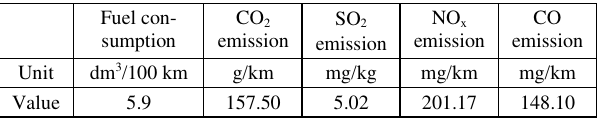
Table 9. Fuel consumption and pollutant emission of ICEV in the TtW phase – results of RDE test